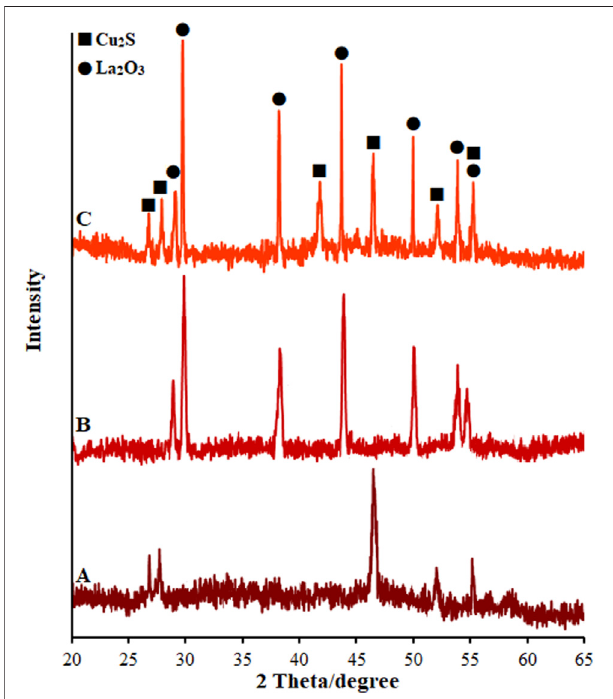
FIGURE 4 | XRD pattern of (A) SF-L Cu 2 S NS, (B) La 2 O 3 NP, and (C) La